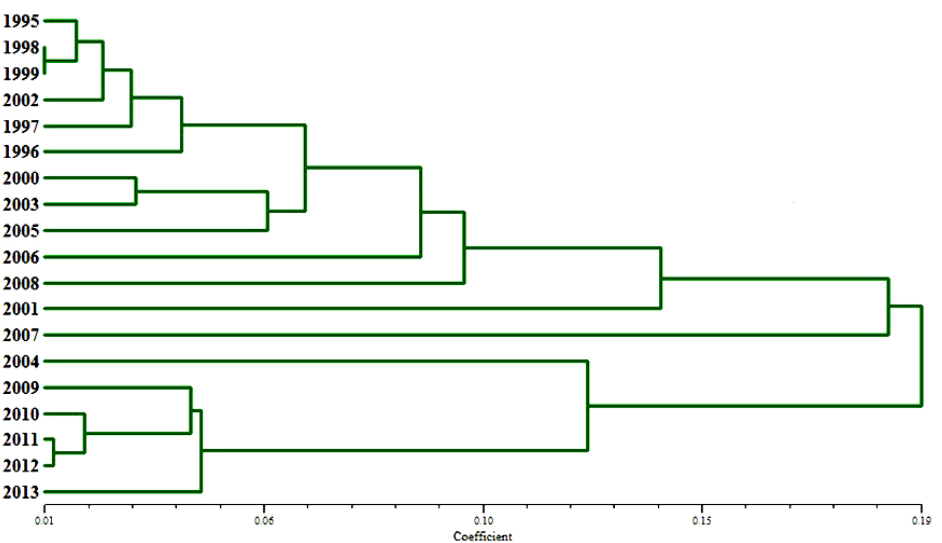
Figure 2. UPGMA dendrogram with regard to Nei’s standard genetic distance between powdery mildew annual populations.